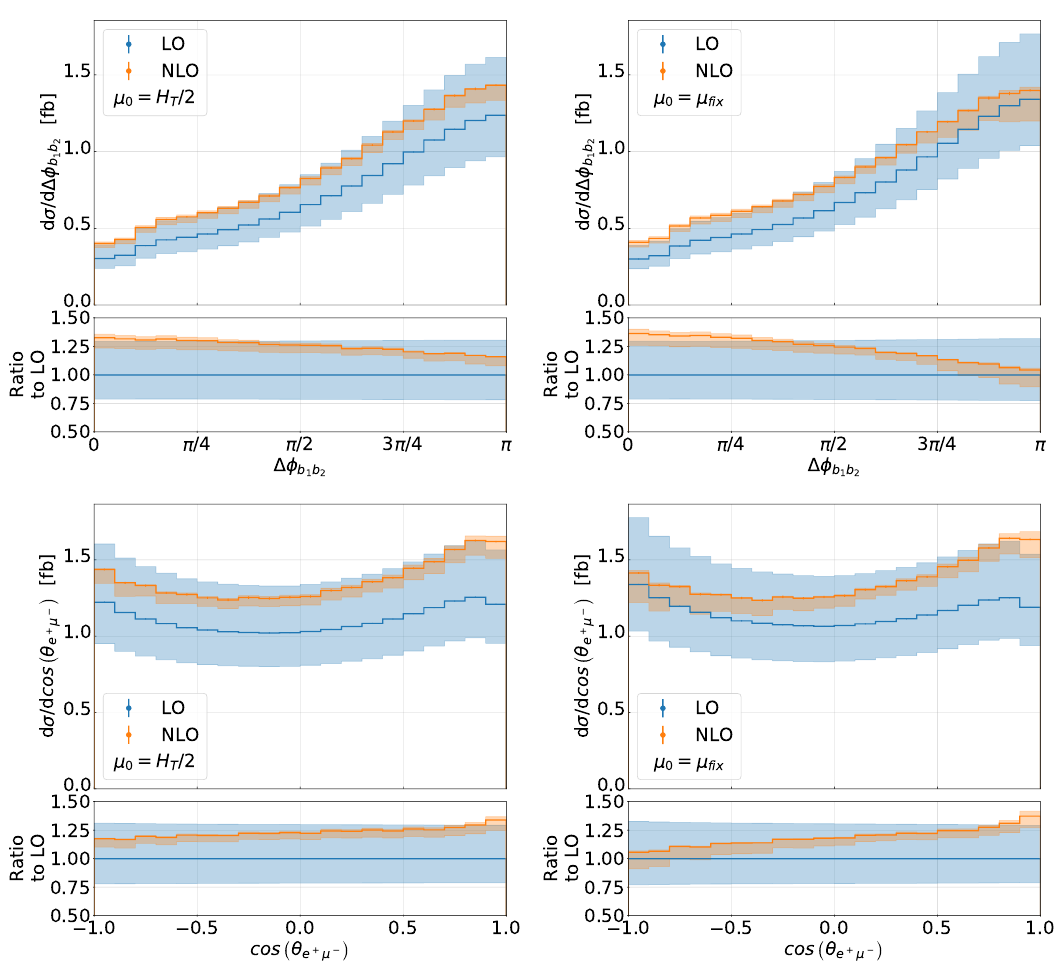
Figure 10 . Differential distributions at LO and NLO QCD with the corresponding uncertainty (cid:0) (cid:1) bands for the observables ∆ φ b and cos θ for the pp → e + ν e µ − ¯ ν µ b ¯ b H process at the LHC e + µ − √ 1 b 2 with s = 13 TeV. Results are presented for µ 0 = H T / 2 and µ 0 = µ fix . The NNPDF3.1 PDF set is employed. Also given are Monte Carlo integration errors. The lower panels display the differential K